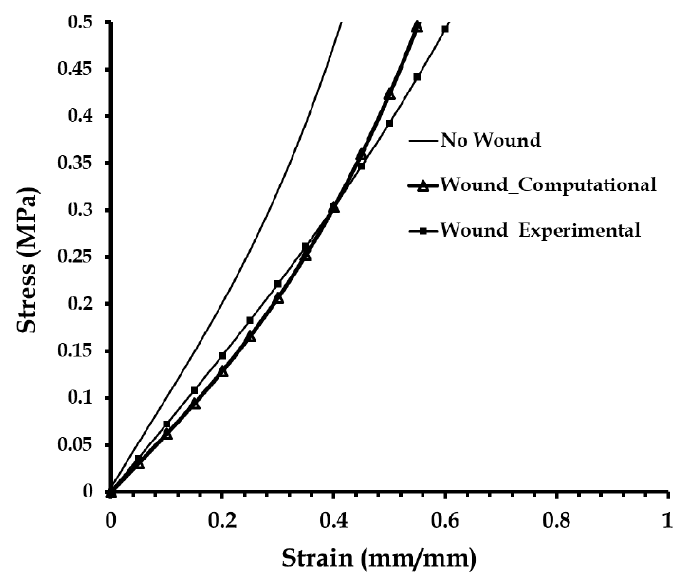
Figure 22. Average Stress ‐ Strain plots of wounded and unwounded skin phantoms.